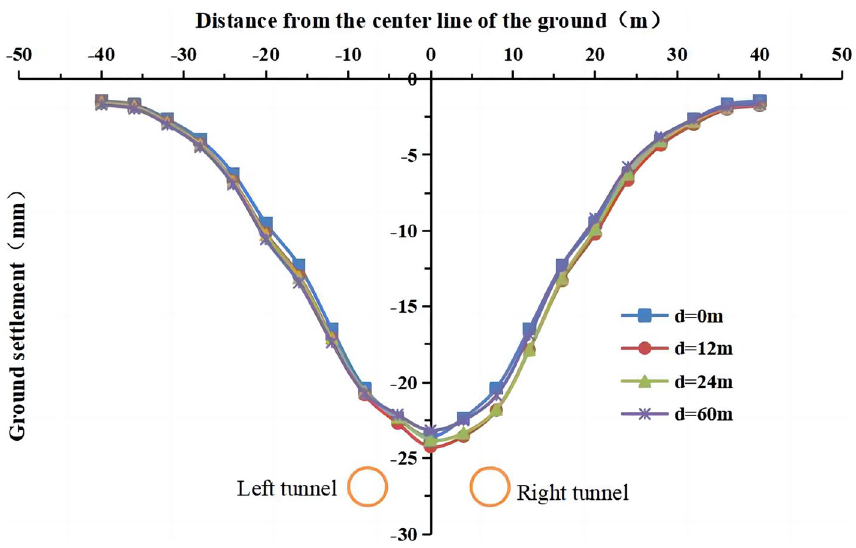
Figure 32. Surface settlement for different section spacings between the left and right